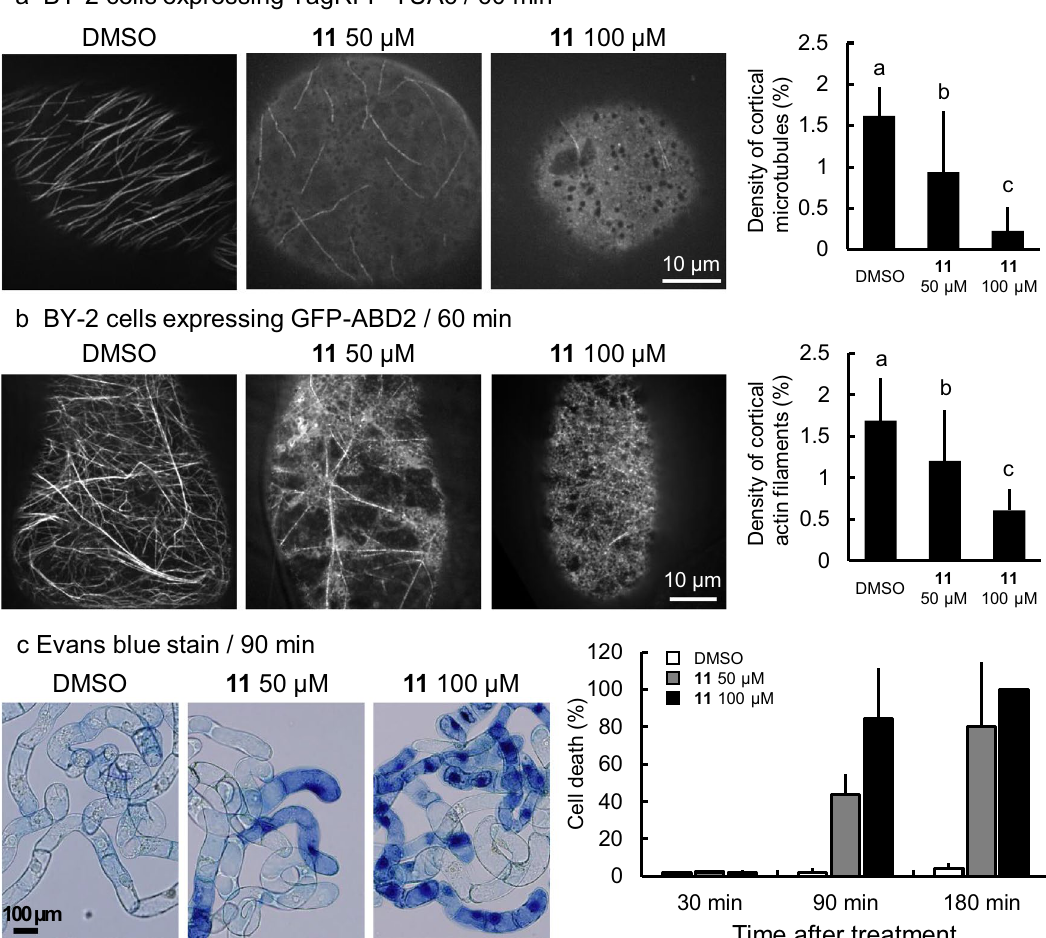
Figure 7. KAND affected cortical microtubules, actin filaments and cell viability in tobacco BY-2 cells. ( a ) Cortical microtubules in BY-2 cells visualized by the presence of TagRFP-TUA6. BY-2 cells treated with KAND 11 (50 μM or 100 μM) or DMSO, were examined using confocal microscopy. The density of cortical microtubules was calculated from micrographs acquired from 25 independent cells. Letters indicate significant differences (Tukey’s HSD test, p < 0.05). Scale bar = 10 μm. ( b ) Cortical actin filaments in BY-2 cells visualized by the presence of GFP-ABD2. BY-2 cells treated with KAND 11 (50 μM or 100 μM) or DMSO were examined using confocal microscopy. The density of cortical actin filaments was calculated from micrographs acquired from 25 independent cells. Letters indicate significant differences (Tukey’s HSD test, p < 0.05). Scale bar = 10 μm. ( c ) Dead BY-2 cells visualized by Evans blue staining. BY-2 cells treated with KAND 11 (50 μM or 100 μM) or DMSO were examined by bright field microscopy. n = 3. Scale bar = 100